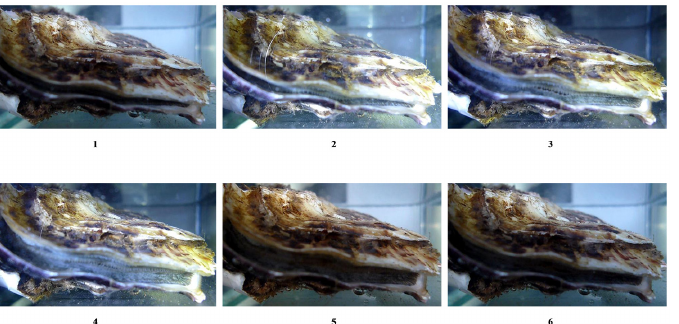
Fig 1. Responses of oysters to turning the flashlight on and off. 1, oyster filtering seawater with a slightly-opened shell prior to switch-on; 2, oyster immediately after switch-on; 3, oyster beginning to open its shells during switch-on; 4, oyster with a wider shell opening during switch-on; 5, oyster beginning to close its shell following switch-off; 6, reduction in size of shell opening following the disappearance of flashlights for several seconds. The ‘ switch-on ’ indicates the time when the flashlight is switched on; ‘ switch-off ’ indicates the time when the flashlight is switched